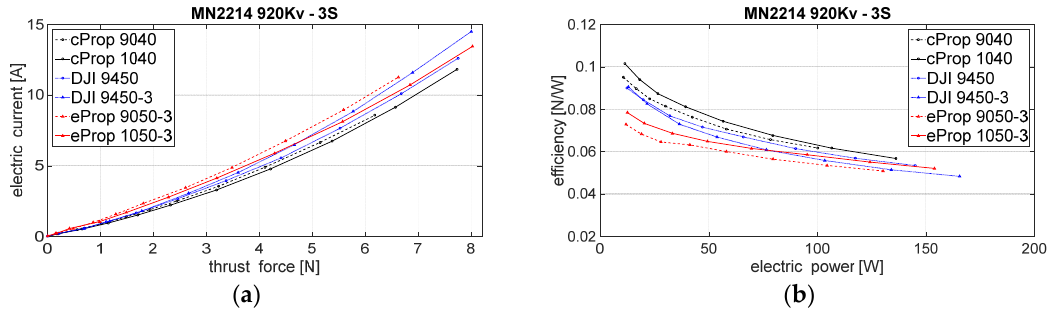
Figure 20. Energy consumption of MN 2214 BLDC motor: ( a ) electric current with respect to thrust force; ( b ) overall efficiency.